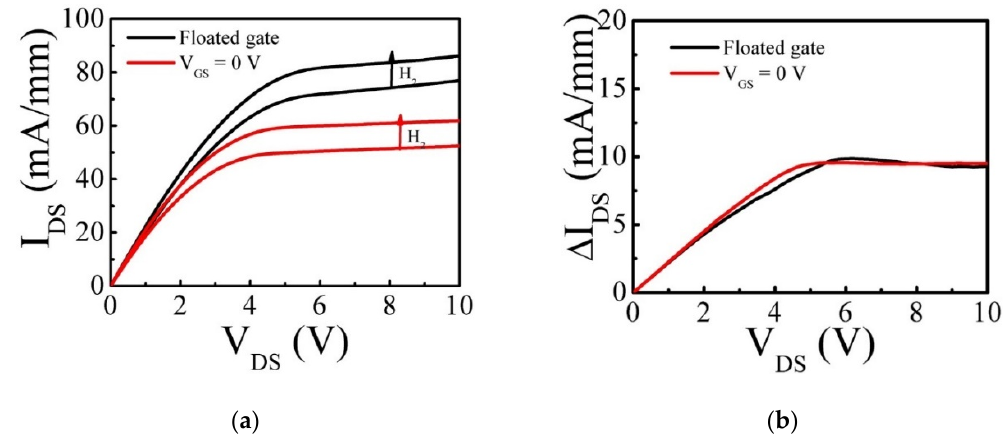
Figure 2. ( a ) Output characteristics of a 3-terminal standard Pt/AlGaN/GaN HEMT-based sensor (no recess) in the air and in H 2 at 200 °C with a floating gate and V GS = 0. ( b ) Δ I DS = I H 2 − I air for each case.